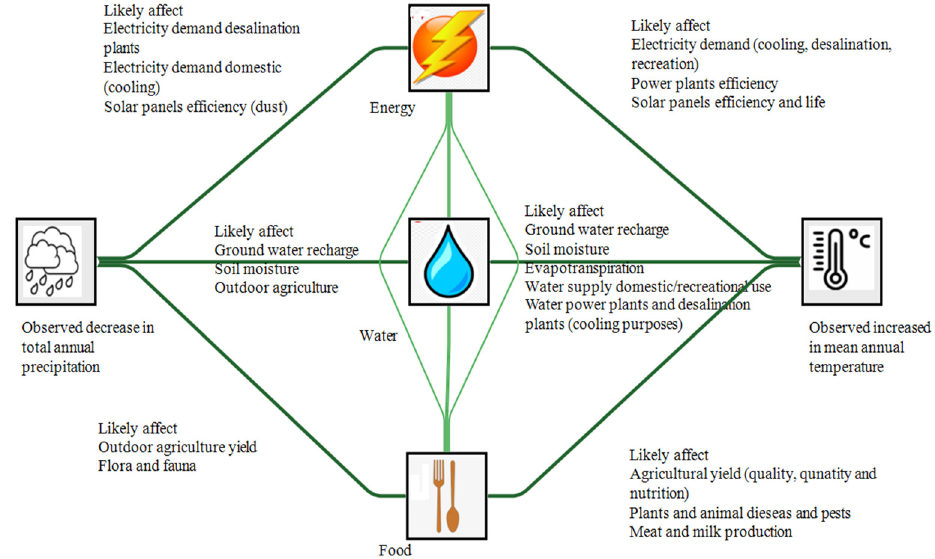
Figure 12. Possible impacts of observed climatic changes on the EWF nexus.